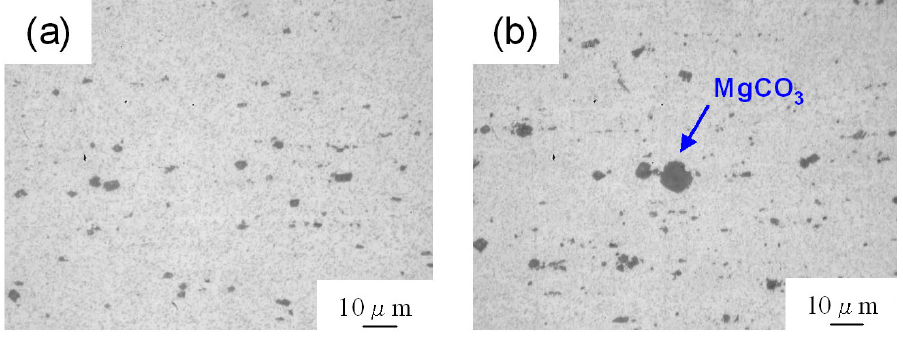
, ρ : 2.70 g/cm 3 3